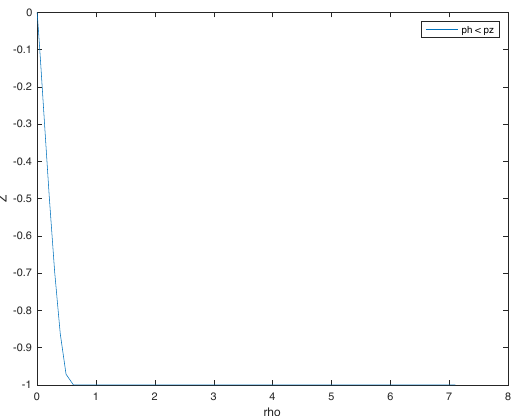
Figure 38. Trajectories in the ( ρ , z ) plane for starting points ( ρ 0 , z 0 ) = ( 1, − 1 ) and considering p z = p h p z = p h ; p z = p h . Even at the situation at which the vertical behaviour is the slowest one, the motion 8 4 remains tangent to the vertical axis.